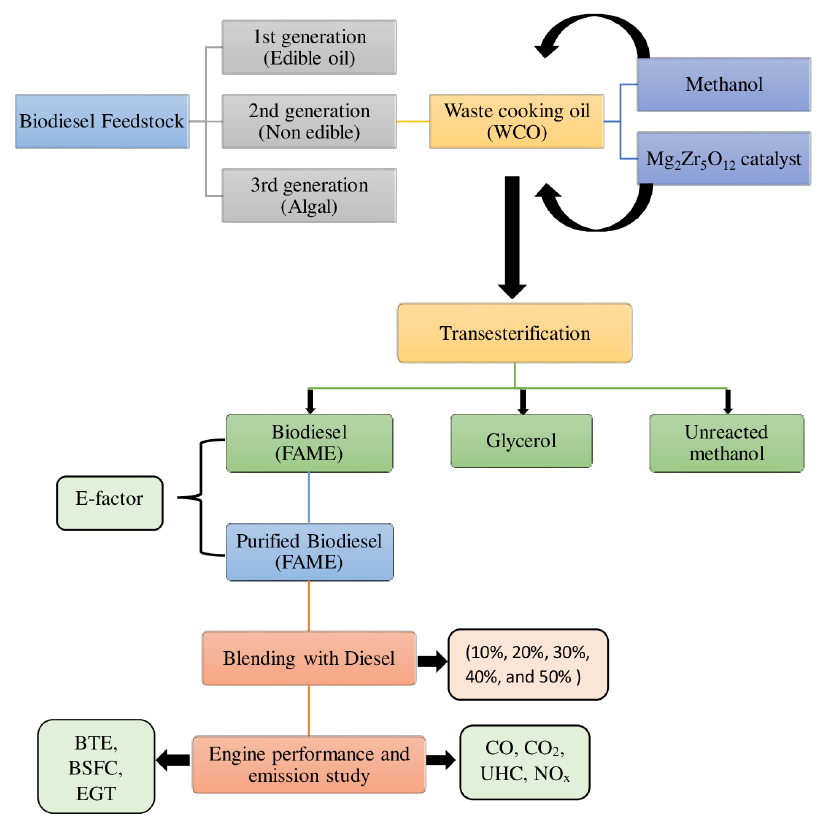
Figure 1. Flowchart of the experimental approach for the present study.